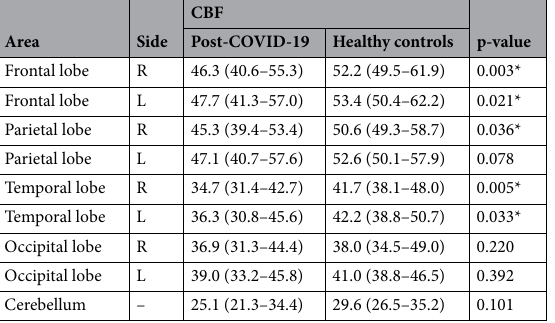
Table 4. Median (IQR) of regional mean CBF values (ml/100 g/min) of post-COVID-19 subjects and healthy controls at the various ROIs and comparison between two groups. *Statistically significant